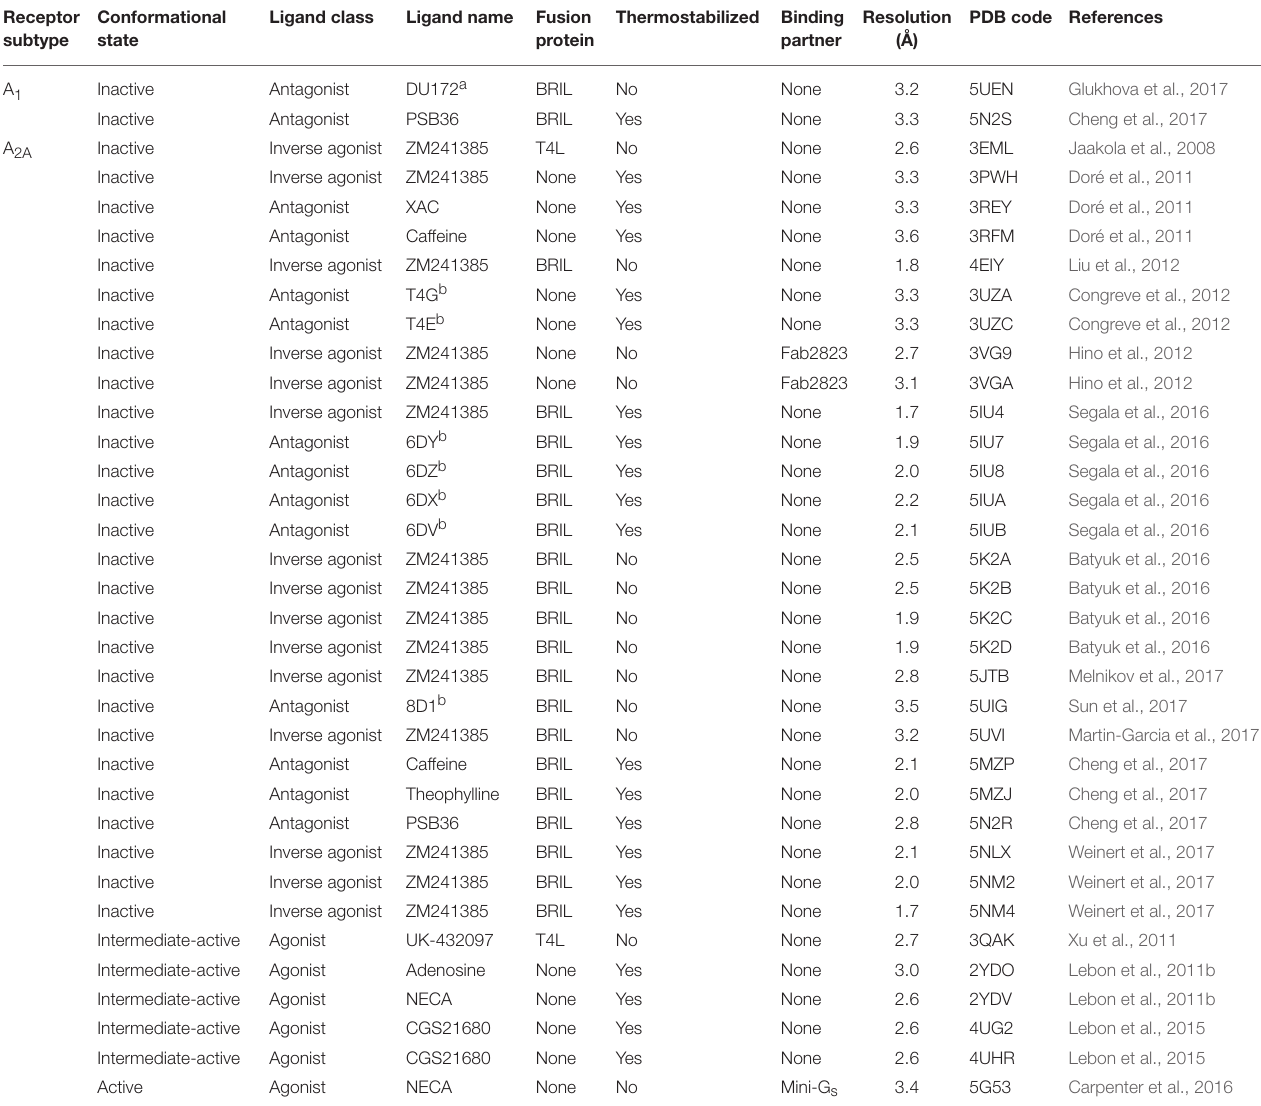
TABLE 1 | Adenosine receptor X-ray crystal